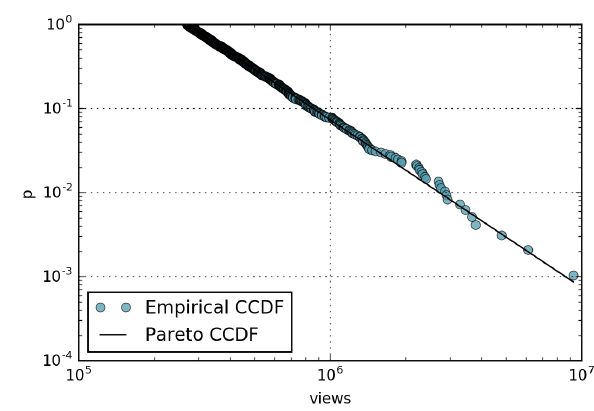
Figure 1. Complementary cumulative distribution function (CCDF) of page views computed for the 1000 most popular Wikipedia pages in July 2016.